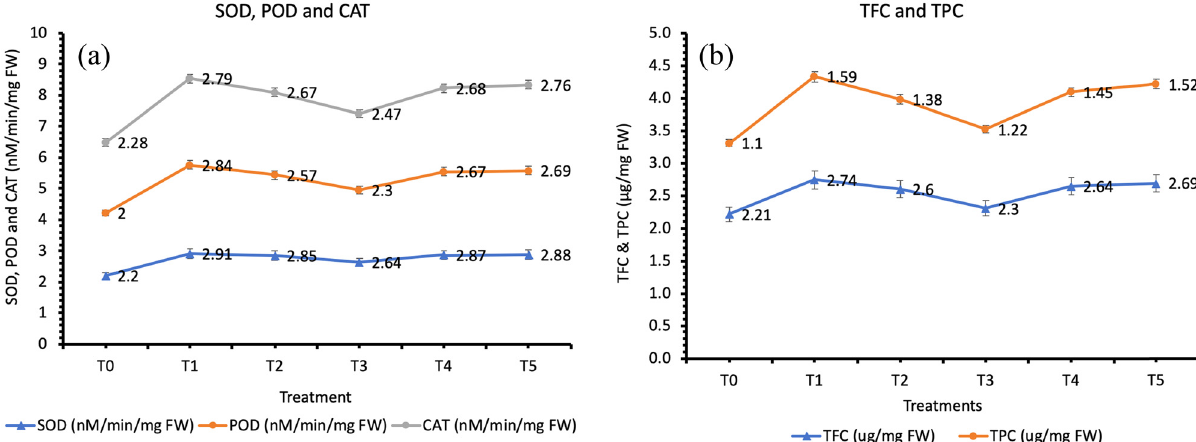
Figure 3: E ff ect of di ff erent treatments of AgNPs on enzymatic and nonenzymatic parameters of rice plants under biotic stress: ( a ) super - oxide dismutase, peroxidase, and catalase activity and ( b ) total phenol and fl avonoid contents. Note: T0: control; T1: A. fl avus ( pathogen ) ;